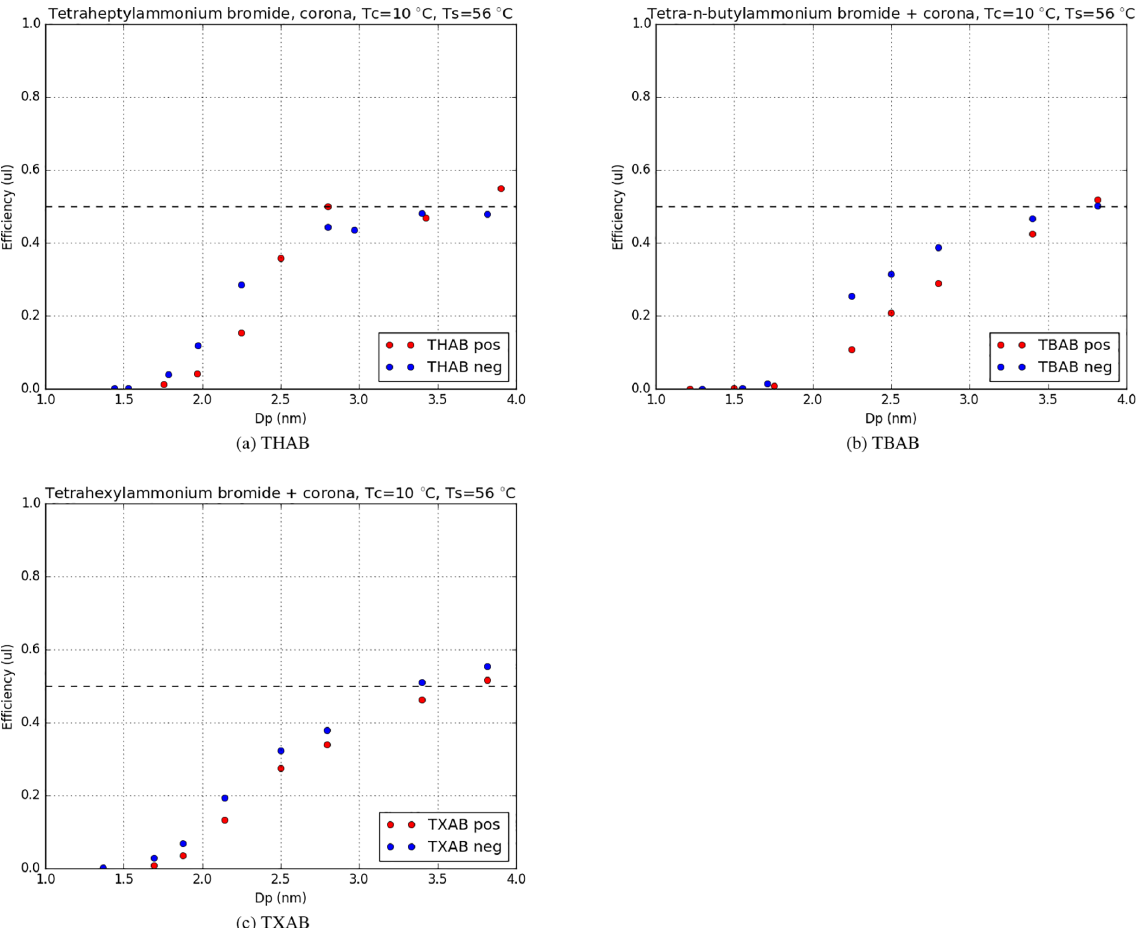
Figure 4. Detection efficiency curves measured for various laboratory-generated